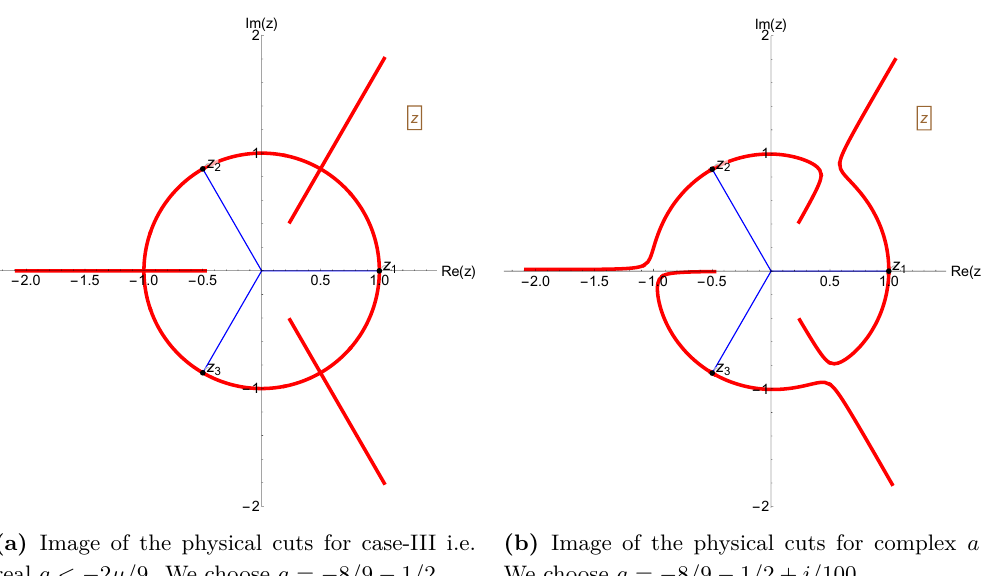
(a) Image of the physical cuts for case-III i.e. (b) Image of the physical cuts for complex a . real a < − 2 µ/ 9 . We choose a = − 8 / 9 − 1 / 2 . We choose a = − 8 / 9 − 1 / 2 + i/ 100 . Figure 4. Image of the physical cuts in the complex z -plane. We choose µ = 4 for the above plots.